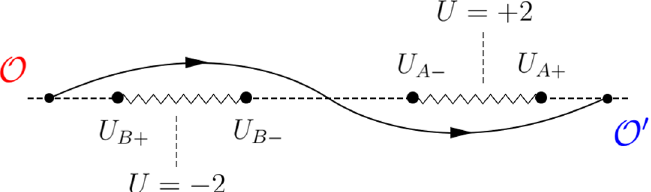
Figure 4 . The path in the U -plane connecting two observers O and O 0 probing the two holonomy saddles for SU(2) 0